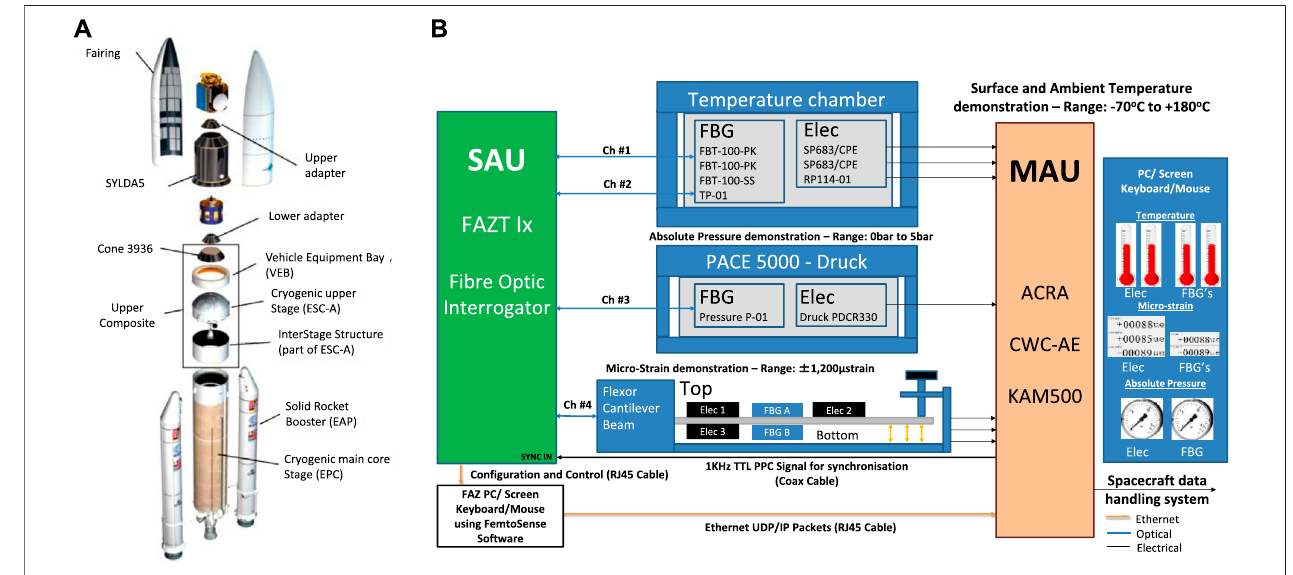
FIGURE 8 | (A) Diagram of Ariane 5 Sections, (B) TMSS Demonstrator Overview 5.